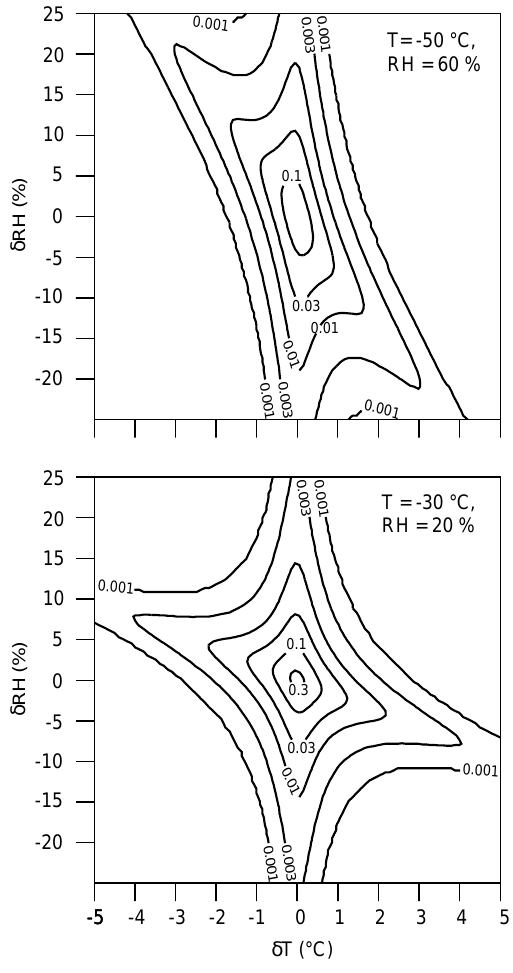
Fig. 5. Contours of the theoretical joint probability density (jpd) f